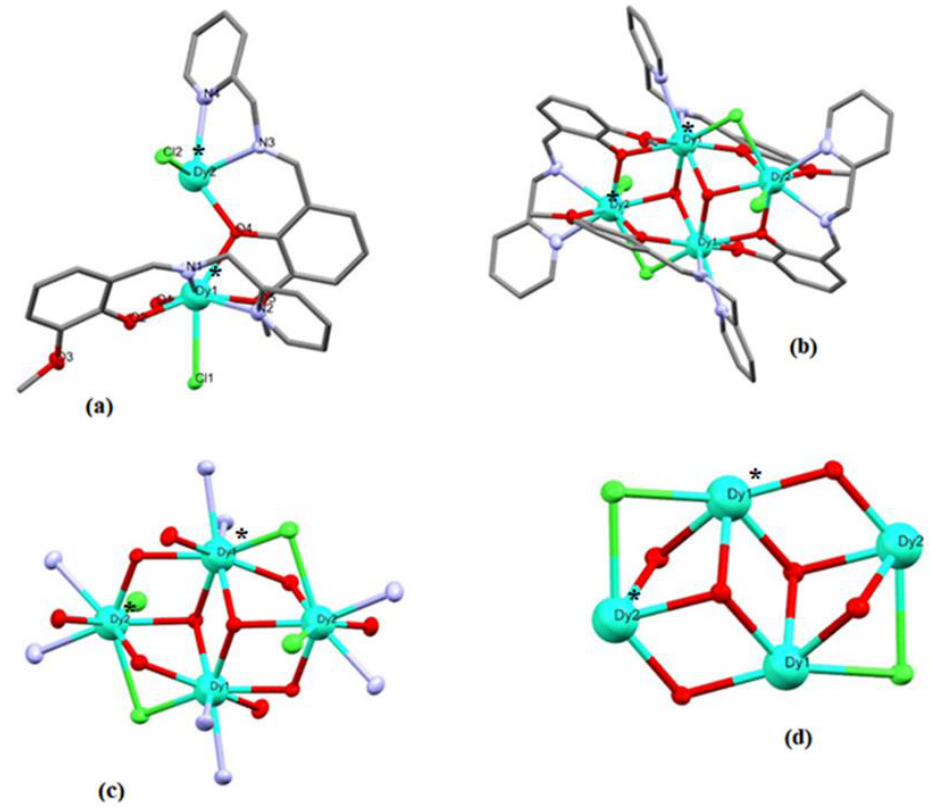
Figure 1. ( a ) Asymmetric unit of complex 1 ( b ) Full molecular structure of complex 1 ; ( c ) The dysprosium core structure with coordinating atoms from each ligand for complex 1 ( d ) The dysprosium central core of complex 1 : Carbon atoms in ( c,d ) and hydrogen atoms in all the figures are omitted for clarity. Symmetry code (1-x, 1-y, -z). Color codes: cyan Dy (III), red O , black C , blue N , and green Cl and * represents symmetry generated atom.